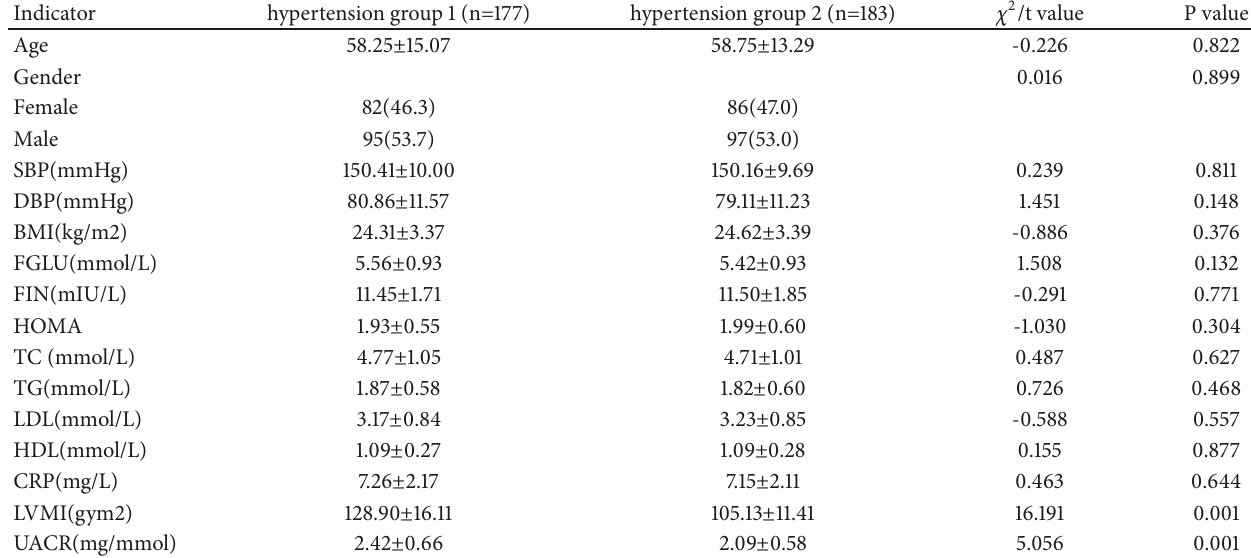
Table 2: Clinical and biochemical characteristics of hypertension group 1 and hypertension group 2 (x ±